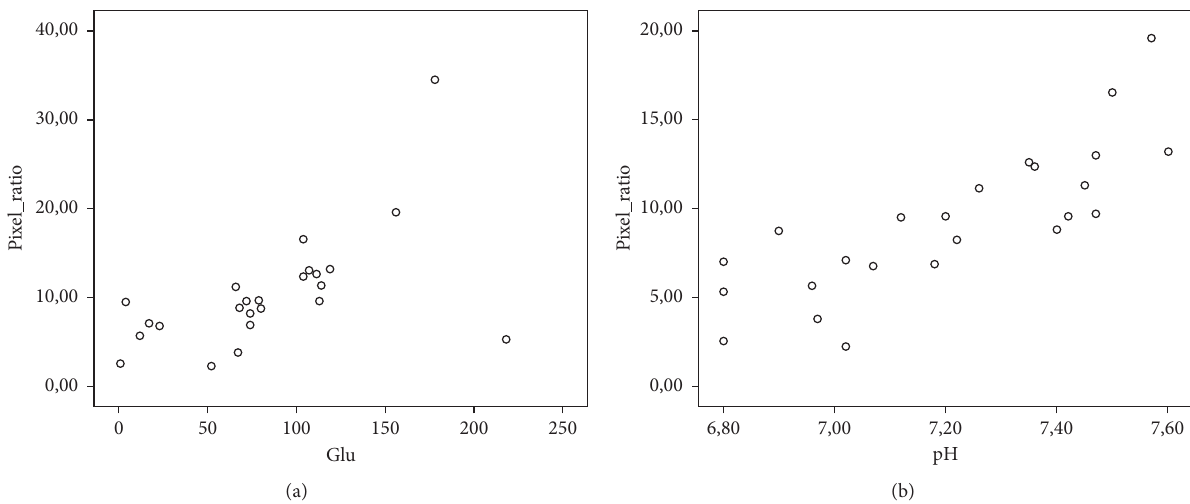
Figure 2: Scatterplot of the predictors (glucose and pH) joining the regression model with the dependent variable (hypoechogenicity index, HI) ( p � 0 . 022, r � 0.474 for glucose, p < 0 . 001, r � 0.811 for pH). Pixel ratio stands for HI.